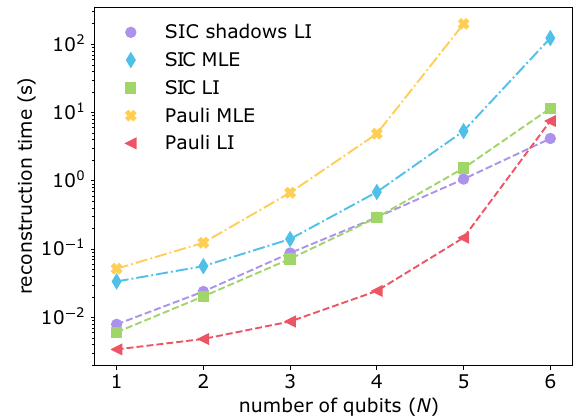
1 6 number of qubits ( N FIG. 3. Classical run time comparison for tomographic recon- struction methods. Comparison of the computational run time for state reconstruction using LI [Eq. (2)] or MLE [Eq. (3)] for both Pauli [Fig. 1(c)] and SIC tomography [Fig. 1(d)], as well as SIC-based classical shadows [Eq. (4)] as a function of the system size. For each qubit number N , the reconstruction con- siders M = 100 · 3 N experimental shots (i.e., 100 shots per Pauli basis; see the text). The analysis is conducted on a standard desk- top computer and plotted double logarithmically in the number of experimental shots. We find that both MLE methods require the highest computational resources, with SIC MLE significantly faster as the processed dimension is lower with 4 N · 4 N compared to 6 N · 4 N for Pauli tomography. LI with SIC measurements shows an initial time offset to Pauli tomography arising from han- dling ququart (dim = 4 N ) instead of qubit data (dim = 2 N ), but grows much more slowly with system size. Among the LI meth- ods, we find the classical shadow reconstruction to be the fastest for an increasing number of qubits, as it accumulates each indi- vidual shot in dimension 2 N · 2 N [see Eq. (4)], avoiding the costly matrix inversion in dimension 4 N · 4 N or 6 N · 4 N as required for SIC and Pauli tomography,